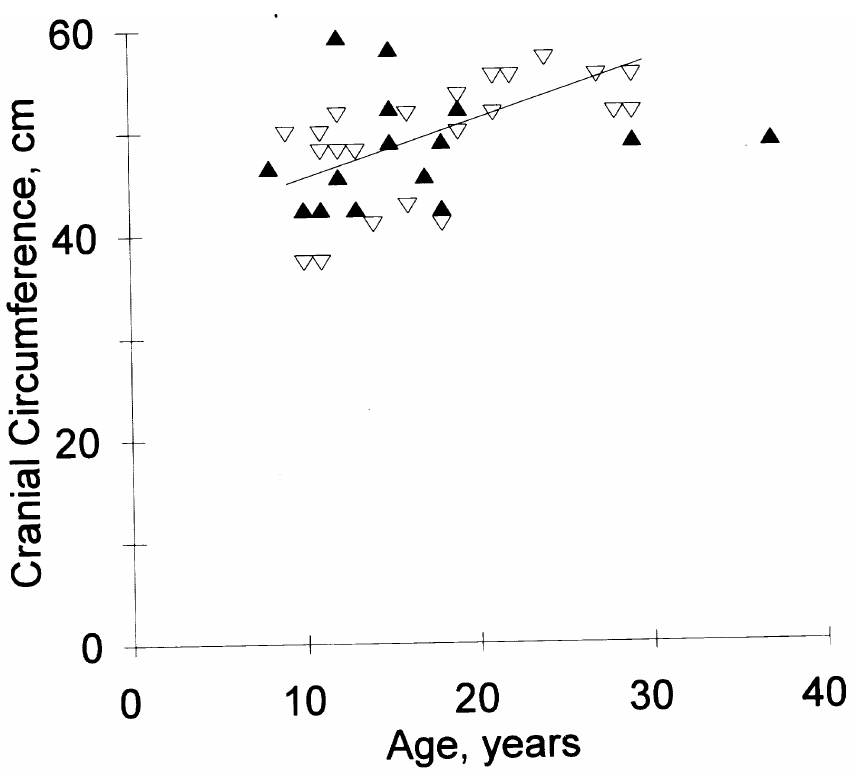
Fig. 4. Shows the cranial circumference in cm as a function of age. ( 4 ) GTS males, ( 8 ) control